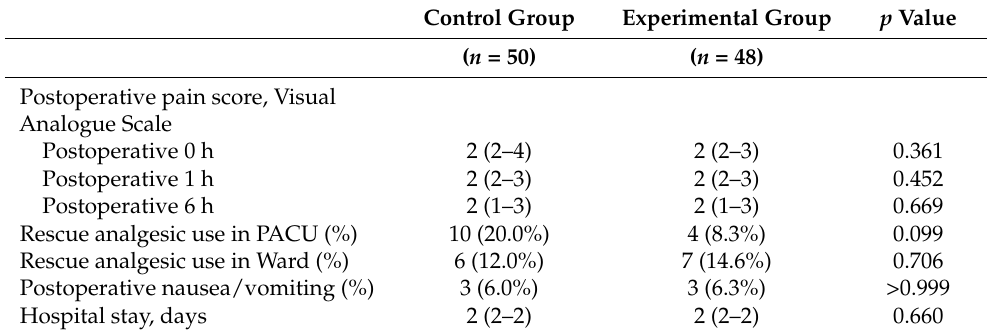
Table 4. Comparisons of postoperative recovery findings between the control and experimental groups. Control